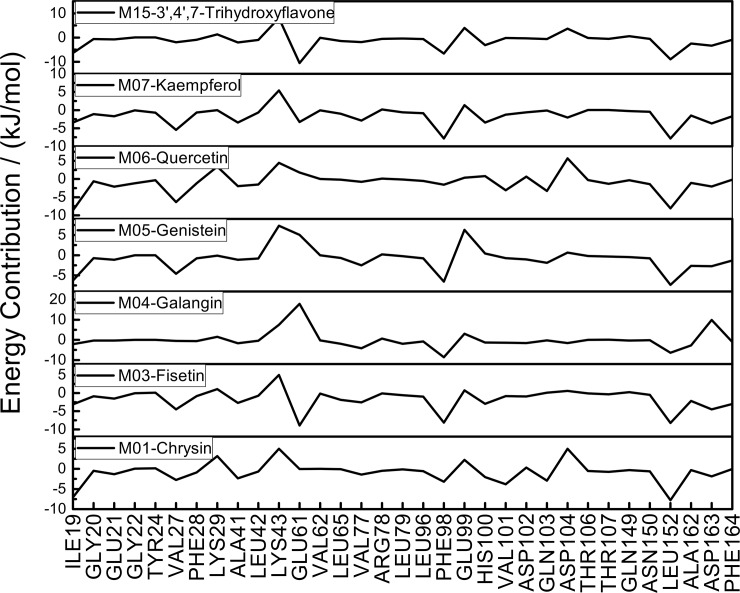
Per residue decomposition energies (ΔGbindresidue) of crucial amino acids in various inhibitors.